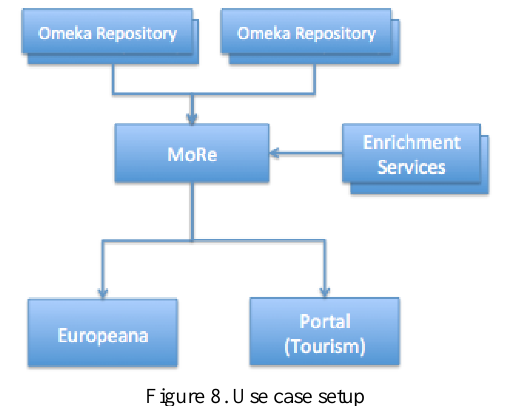
Figure 8. Use case